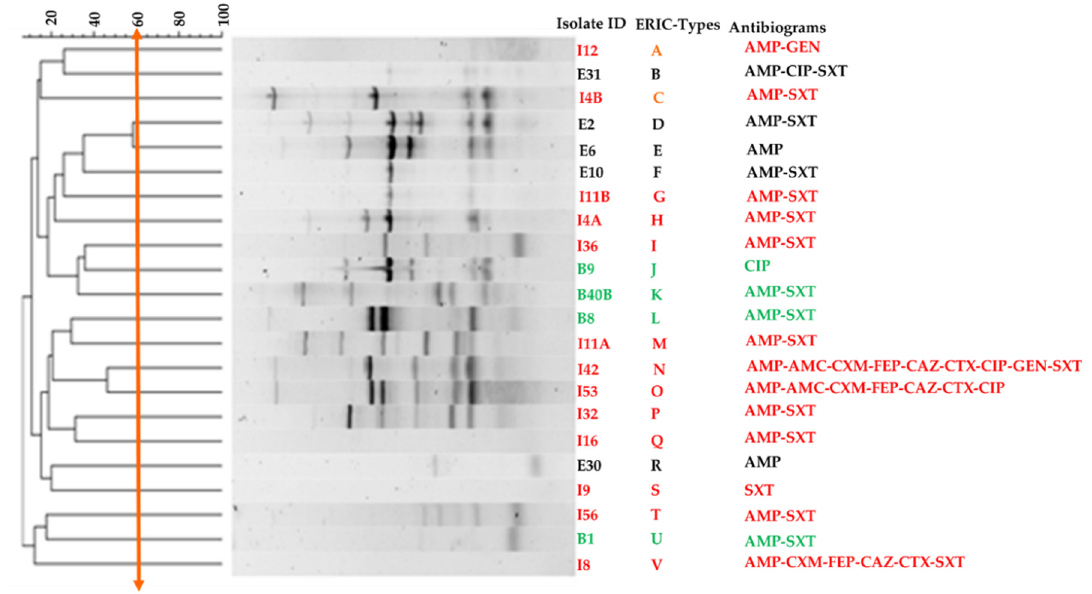
Figure 3. Dendrogram showing cluster analysis of the antibiotic-resistant UPEC strains isolated from urine samples. The solid orange line represents ERIC_Types cut off. The colors on the annotations represent the isolate sources: Bruntville (green), Eastboom (black), Imbalenhle (red).